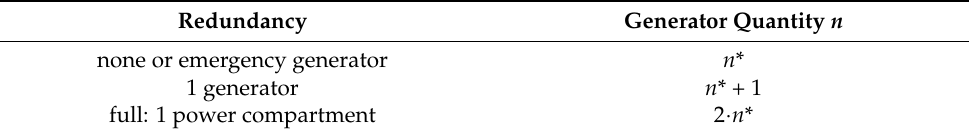
Table 2. Number of generators